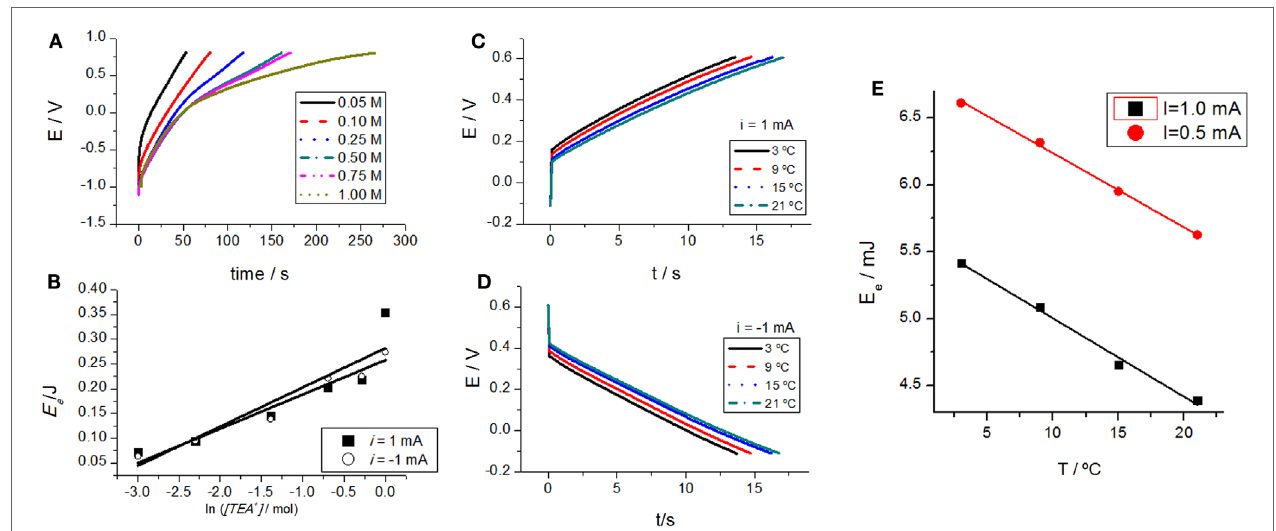
FiGURe 4 | (A) Evolution of the CNT film potential in aqueous solutions with different concentrations of TEABF 4 : 0.05, 0.1, 0.25, 0.5, 0.75, and 1 M under flow of an anodic constant current of 0.5 mA. (B) Parallel evolution of the consumed electrical energy attained by integration of (A) . (C) Chronopotentiometric responses in 0.1 M TEABF 4 aqueous solution at different temperatures: 3, 9, 15, and 21°C under flow of 1 mA. (D) Chronopotentiometric responses in 0.1 M TEABF 4 aqueous solution at different temperatures: 3, 9, 15, and 21°C under flow of − 1 mA. (e) Consumed electrical energy after 13 s of current flow (after consumption of the same charge and for a constant concentration of active centers) at different temperatures under flow of different anodic constant currents: 1 or 0.5 mA. Reproduced from Martinez et al. (2012), with permission from